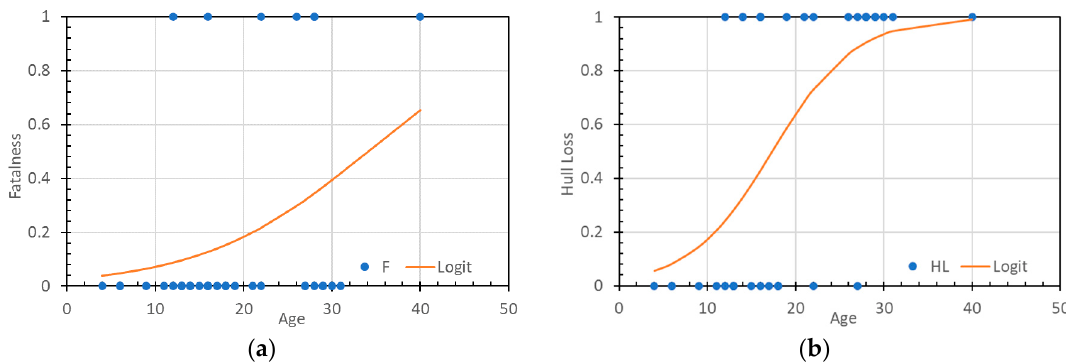
Figure 12. Results for the logistic regression investigating the effect of aircraft age on: ( a ) fatalness of maintenance accidents (0 = no fatalities, 1 = fatalities); ( b ) aircraft damage from maintenance accidents (0 = aircraft repaired, 1 = aircraft damaged beyond repair = hull loss).